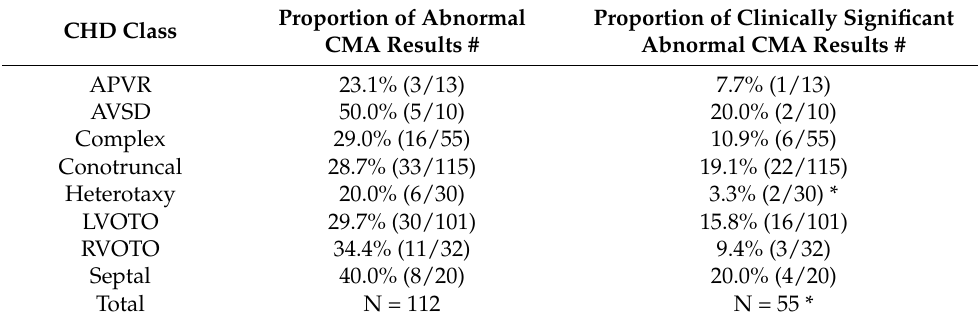
Table 2. Proportion of chromosomal microarray abnormalities in CHD classes. CHD Class